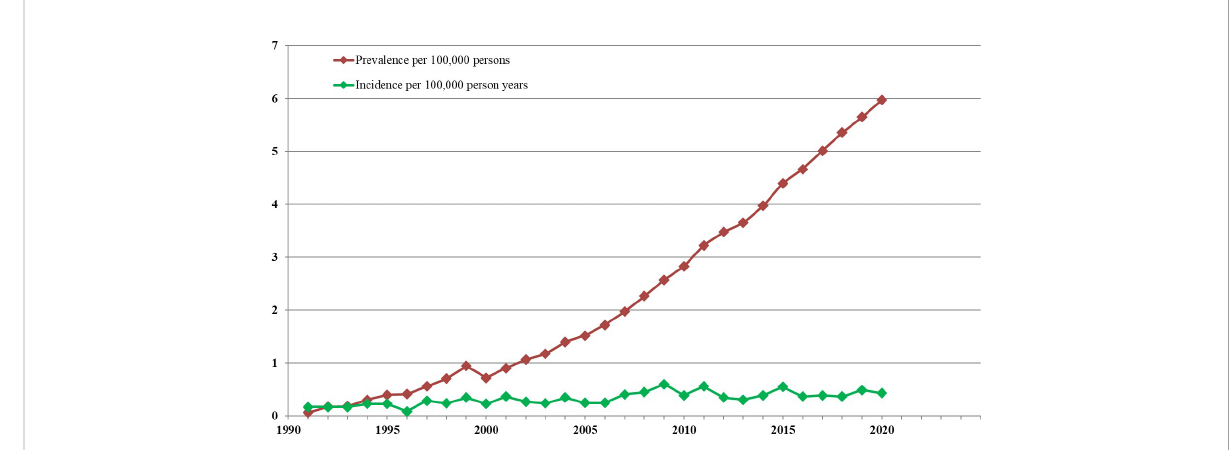
FIGURE 1 APL Incidence and prevalence in Hong Kong from 1991-2020. For the 18 Hong Kong government hospitals with specialised haematology services, annual incidence and prevalence rates were derived, assuming an average HK population of 7.5 million throughout those years. These estimates were based on available details in the computerised Clinical Data Analysis and Reporting System (CDARS) of the Hospital Authority, Hong Kong. (9) Prevalence refers to numbers of surviving patients diagnosed with APL on December 31 of each year, even if deemed to be ‘ cured ’ . The trend line shows that the point prevalence increased from 0.1 to 6.0 per 100,000 persons between 1991 and